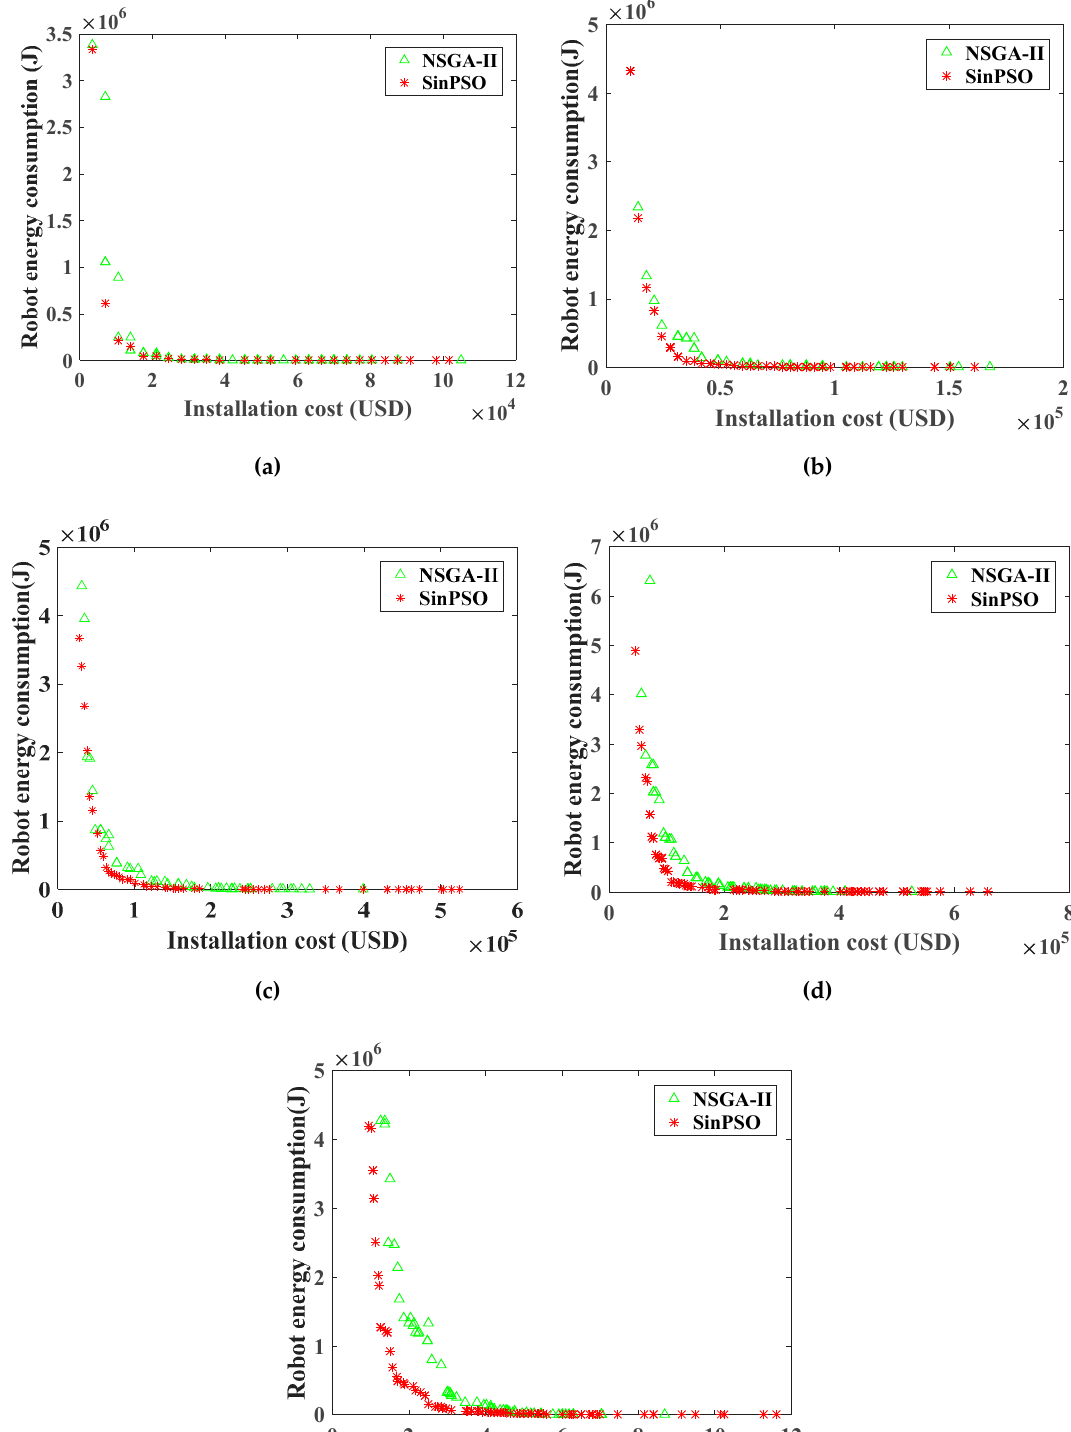
Figure 8. Pareto frontier comparison of deployment cost and optimization objective function of robot energy consumption for WRN by NSGA-II and SinPSO: ( a ) the number of towers is 50; ( b ) the number of towers is 100; ( c ) the number of towers is 200; ( d ) the number of towers is 300; ( e ) the number of towers is 500.